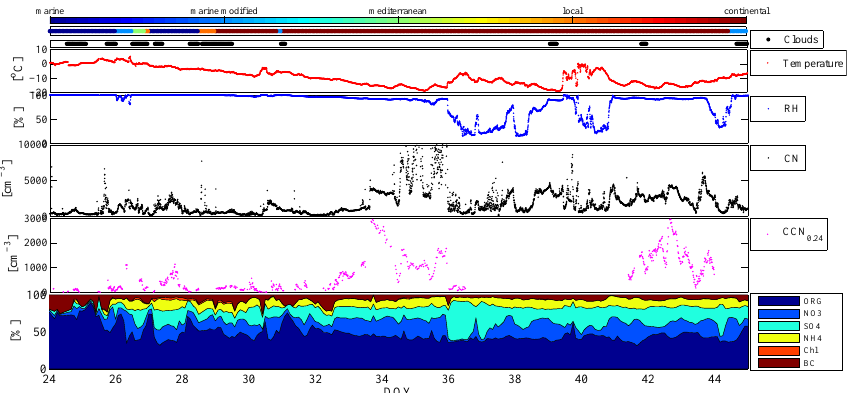
Fig. 3. Overview of conditions during the winter campaign. On panels, from top to down, are shown: air mass type, station inside cloud periods, temperature, relative humidity, total number concentration, CCN number concentration (at 0.24% supersaturation) and AMS volume